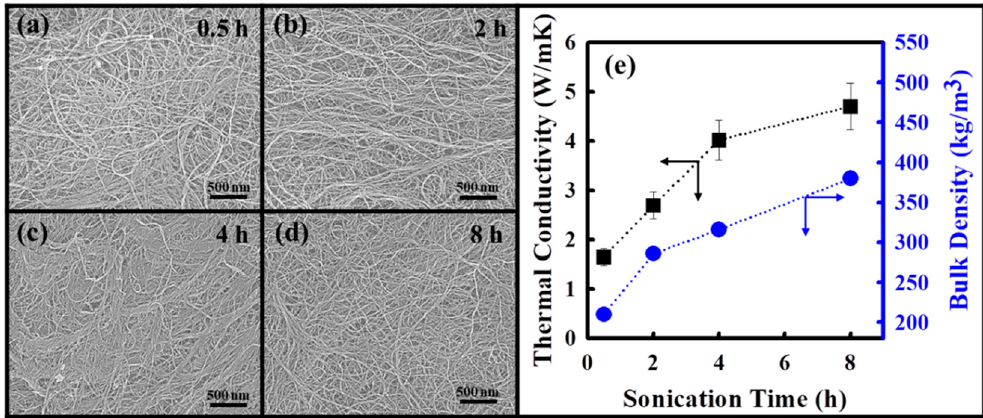
Figure 2. High-resolution scanning electron microscopy (HR-SEM) images of few-walled carbon nanotube (FWCNT) films prepared following ultrasonication for different times: ( a ) 0.5 h, ( b ) 2 h, ( c ) 4 h, and ( d ) 8 h; ( e ) thermal conductivity (black quadrangles and arrows) and film bulk density (blue circles and arrows) of FWCNT films with different sonication times.